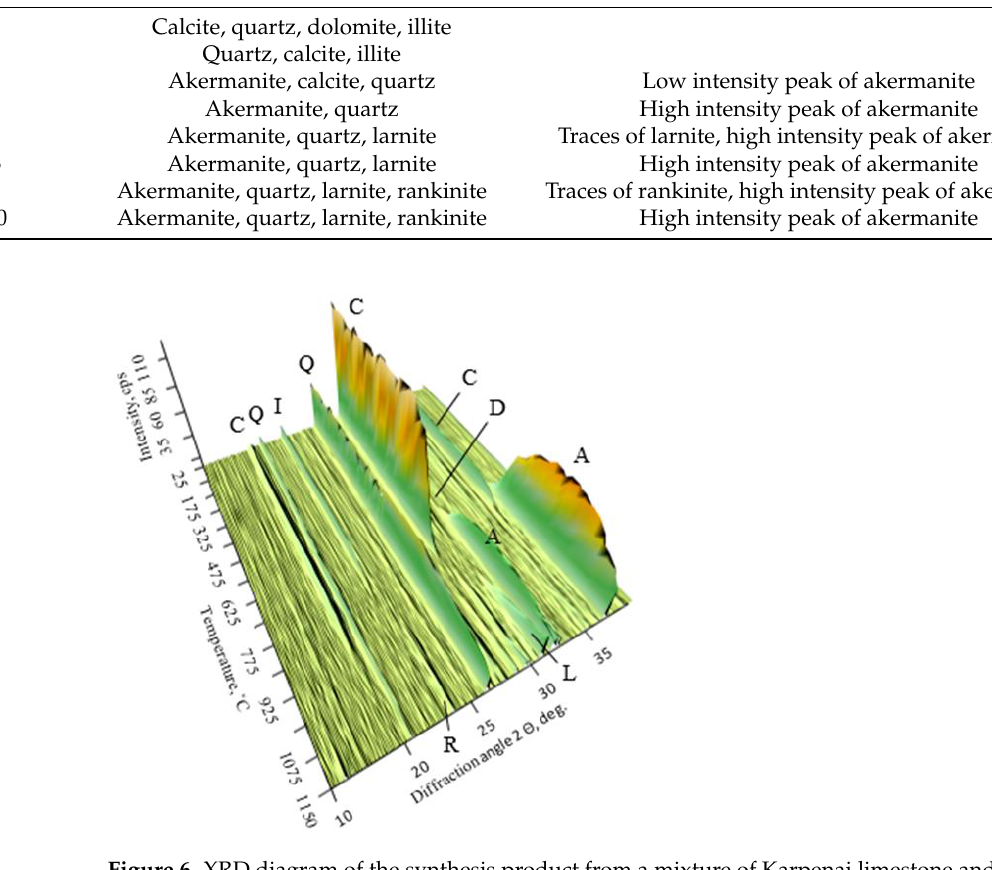
Figure 6. XRD diagram of the synthesis product from a mixture of Karpenai limestone and Saltiskiai clay (CaO/SiO 2 = 1.5) in the temperature range of 25–1150 °C. In the temperature range of 25–625 °C, new compounds are not formed—that is, calcite, quartz, dolomite and illite remain in the raw materials. New compounds are not formed in the temperature range of 25–625 °C; only calcite, quartz, dolomite, and illite remain in the raw materials. Meanwhile, at 650 °C—dolomite and, at 700 °C—illite starts to decompose (Figure 6). Akermanite (PDF No. 00-002-0824) begins to form at 700 ◦ C. The latter compound and quartz do not fully react up to the maximum temperature